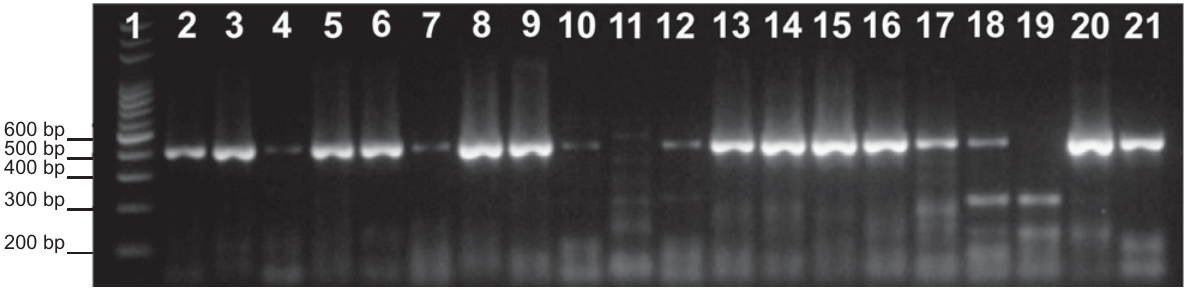
Figure 2- Detection of P. gingivalis, DNA using 2% agarose gel electrophoresis. The gel shows staining for P. gingivalis !&’(cid:9)(cid:4)(cid:2)(cid:26)(cid:20)(cid:15)(cid:17)(cid:3)(cid:22)(cid:9)/(cid:21)(cid:9)(cid:18)(cid:8)(cid:5)<(cid:3)(cid:5)(cid:19)(cid:15)(cid:8)(cid:5)(cid:4)(cid:20)(cid:9)=>?(cid:9)(cid:23)(cid:24)(cid:8)(cid:2)(cid:9)(cid:19)(cid:3)(cid:6)(cid:19)(cid:9)(cid:16)(cid:24)(cid:8)(cid:31)(cid:26)(cid:9)(cid:6)(cid:31)/E(cid:3)(cid:18)(cid:19)(cid:6)(cid:13)(cid:9)J(cid:4)(cid:5)(cid:3)(cid:9)(cid:29)(cid:9)Q(cid:9)(cid:18)(cid:8)(cid:5)(cid:19)(cid:4)(cid:15)(cid:5)(cid:6)(cid:9)(cid:19)$(cid:3)(cid:9)(cid:29)(cid:28)(cid:28)(cid:9)/(cid:26)(cid:9)(cid:2)(cid:8)(cid:20)(cid:3)(cid:18)(cid:31)(cid:20)(cid:4)(cid:24)(cid:9)#(cid:3)(cid:15)(cid:16)$(cid:19)(cid:9)(cid:2)(cid:4)(cid:24)V(cid:3)(cid:24)W(cid:9)(cid:20)(cid:4)(cid:5)(cid:3)(cid:6)(cid:9) 2 to 10, 12 to 18, 20 to 21: positive staining for P. gingivalis DNA; columns 11 and 19 - negative samples for P.